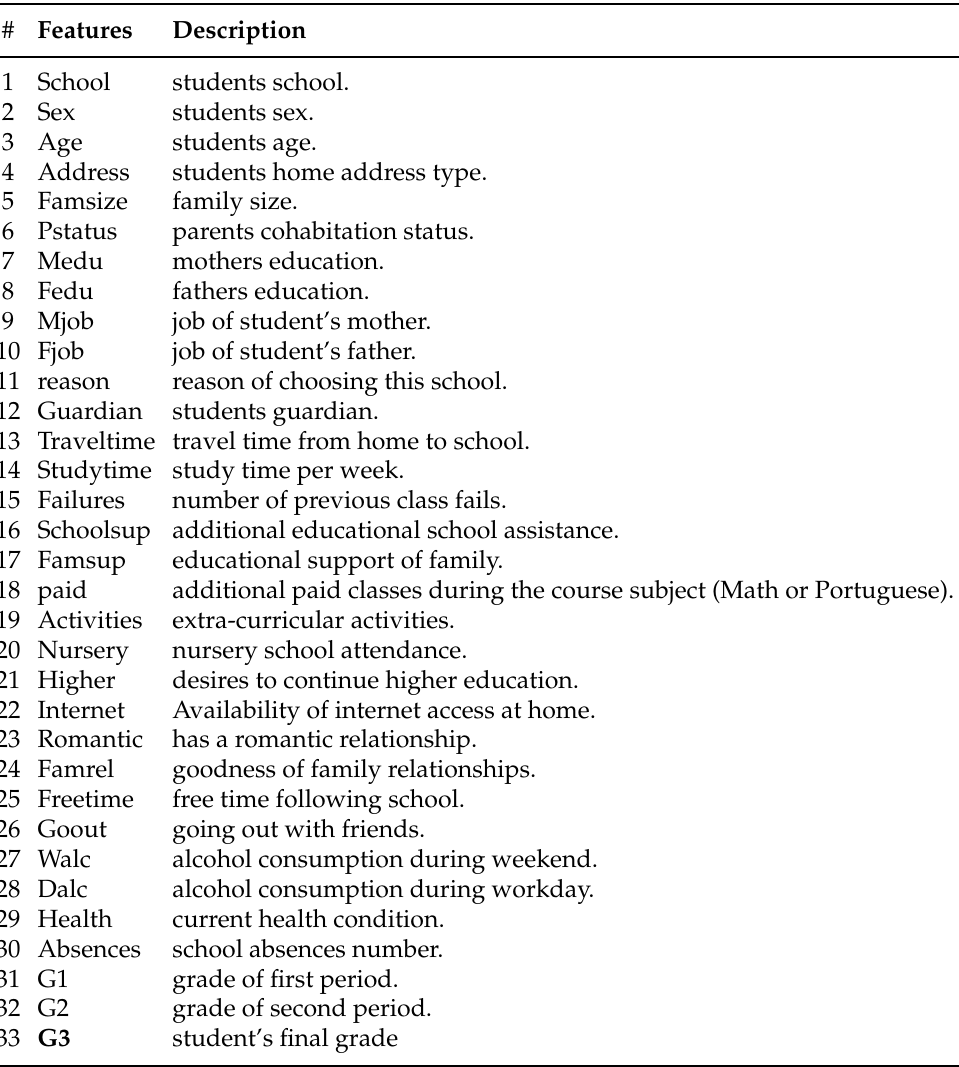
Table A1. Description of features for